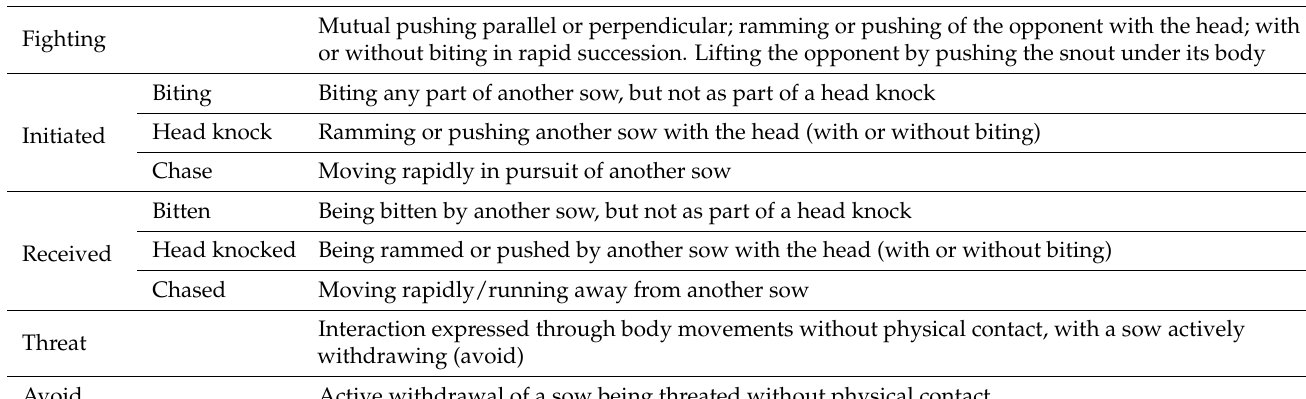
Table 2. Description of aggressive behaviors recorded in the study (adapted from Stewart et al., 2008